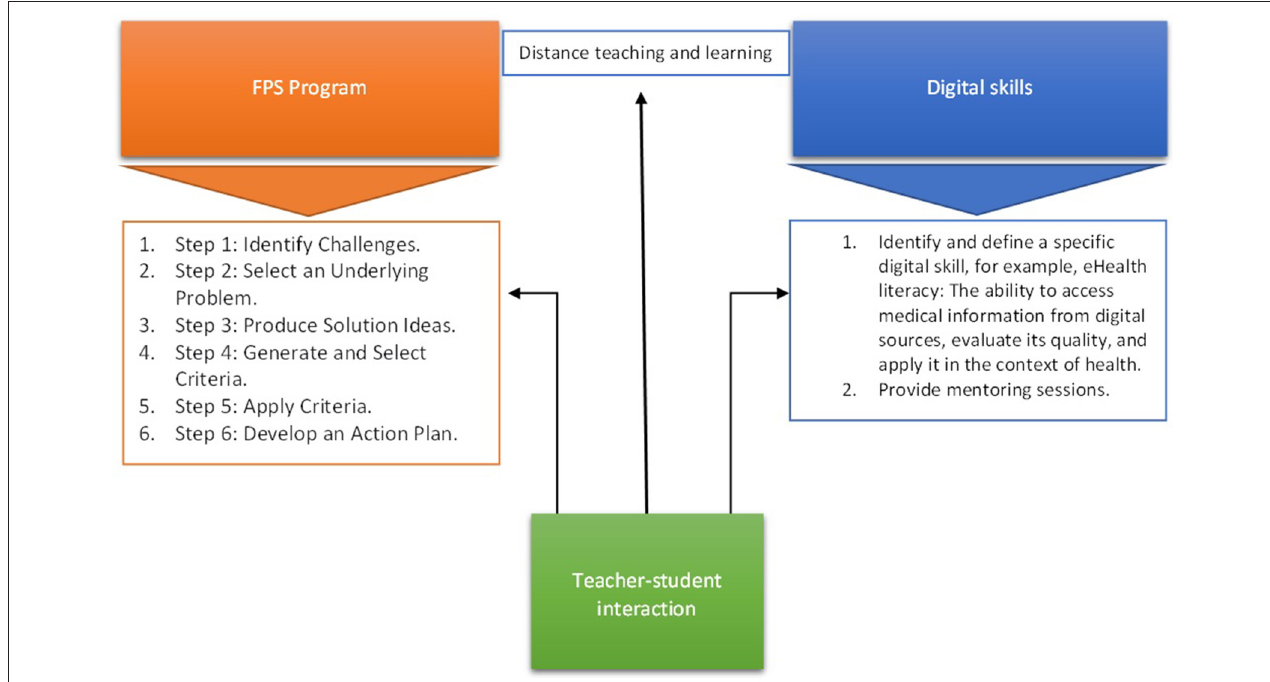
FIGURE 4 | Model 3. Suggested model for the implantation of online FPS program aimed at nurturing students’ digital